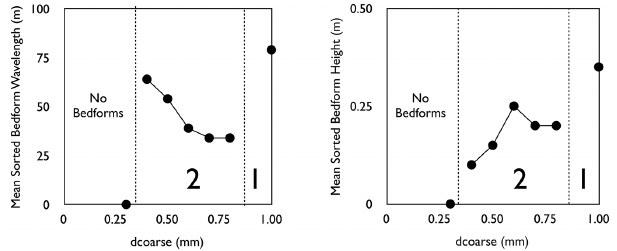
Figure 8. Variations in sorted bedform characteristics (wavelength and height) after 100 days when coarse grain size is held constant. No bedforms appear when the coarse material is too fine. Mode 1 bedforms (long wavelength, larger relief, coarse domains in trough) appear when coarse grain size is large and relatively immobile. Mode 2 bedforms (short wavelength, low relief, coarse domains on updrift flank) appear when coarse grain is between these two limits. No clear pattern was observed after 100 days when d coarse = 0 .